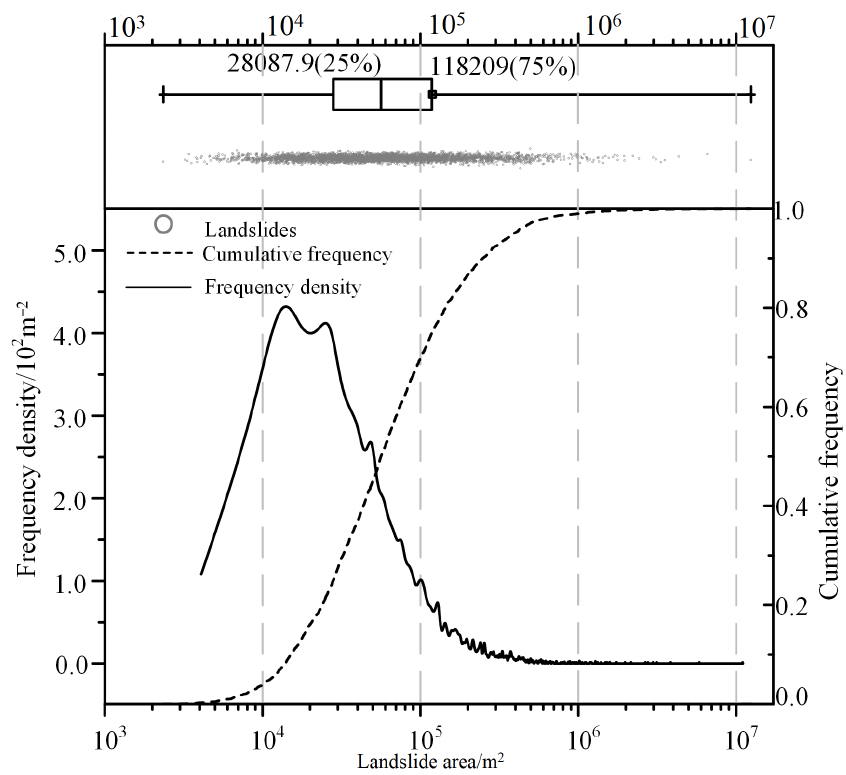
Figure 5. Landslide scale analysis.